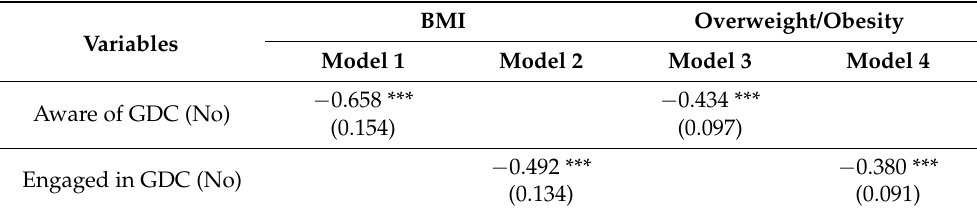
Table 3. OLS and binary logistic regression results of the influence of GDC on children’s BMI and overweight/obesity.